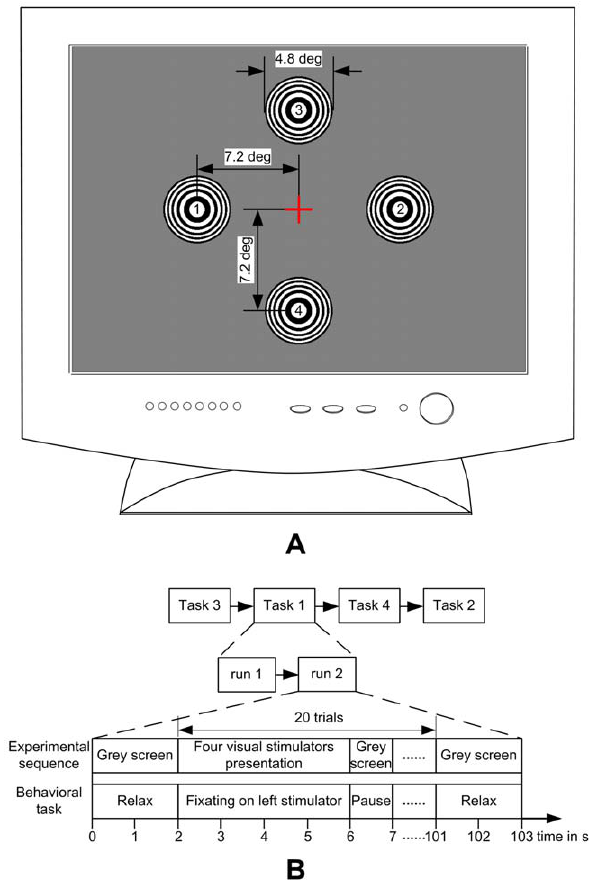
Figure 2. Schematic diagram of the experimental setup. (A) Distribution of four stimulators on the computer screen. The cross indicating the center of the monitor was not presented on the screen. (B) The timing of the experimental sequence and behavioral task. For each subject, four experimental tasks were imposed.